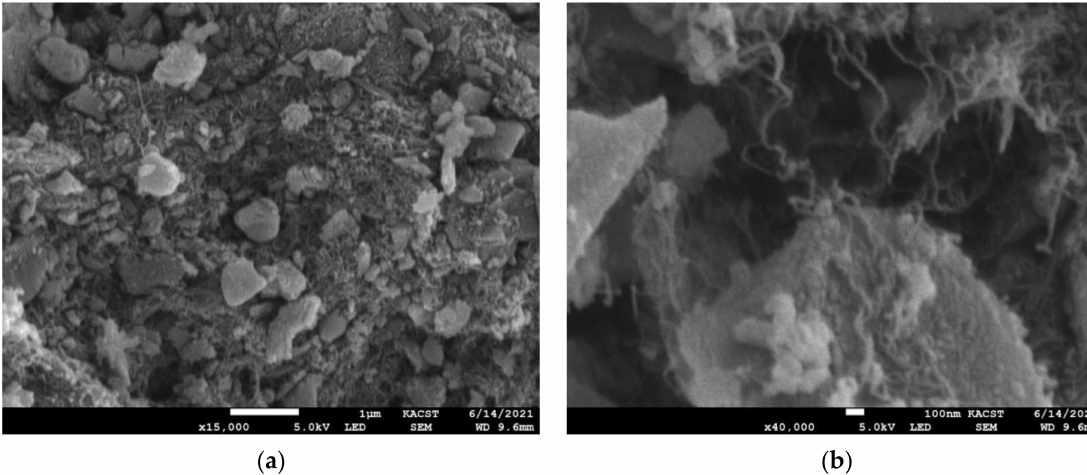
Figure 4. SEM images of 0.25 wt% MWCNT and silica gel composite at ( a ) 1 µ m and ( b ) 100 nm